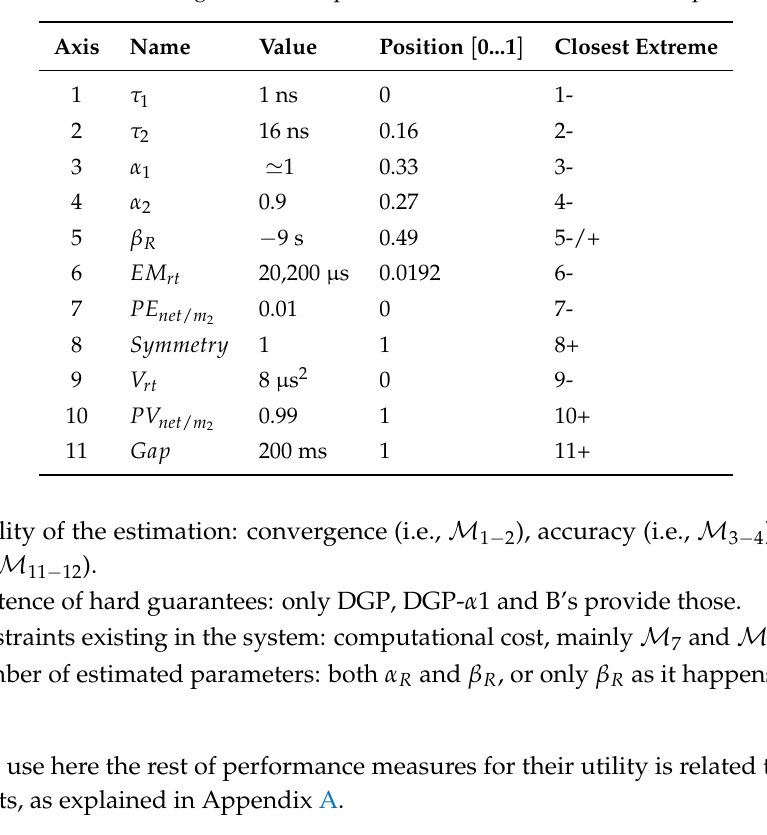
Table 10. Configuration axes positions of the CRUMB robot